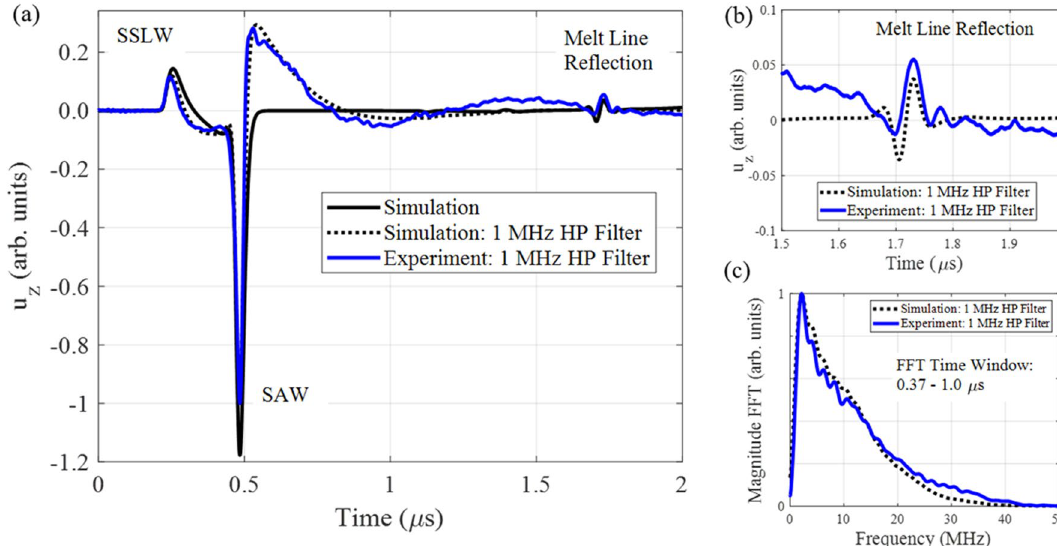
Figure 3. ( a ) Simulated and experimentally measured normal displacement from the pulsed laser excitation. ( b ) Zoomed-in portion of waveform in ( a ) showing the measured scattering from the melt line. ( c ) Magnitude of the Fourier transform of the surface acoustic wave time windowed between 0.37 and 1.0 µ